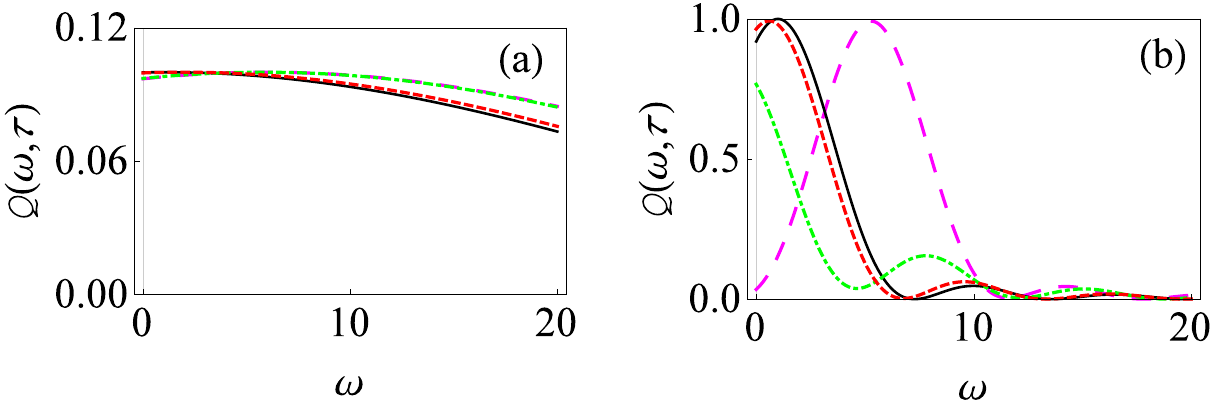
0 and γ( t ) 0 with = = 5 and (cid:31) 5 = =